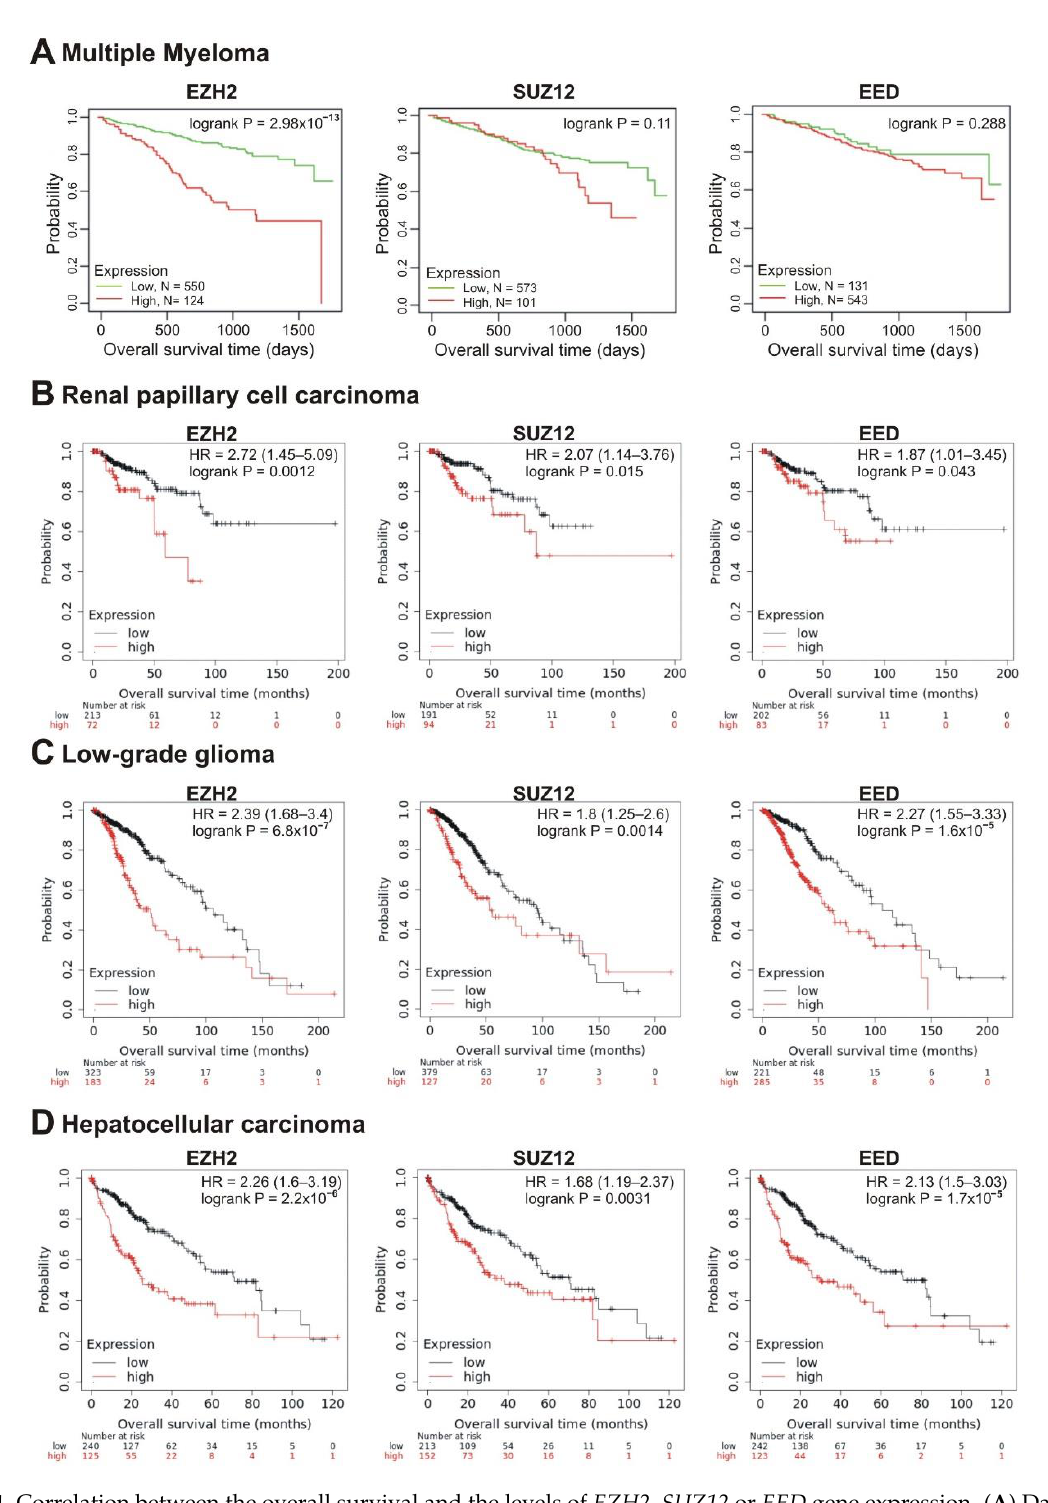
Figure 4. Correlation between the overall survival and the levels of EZH2 , SUZ12 or EED gene expression. ( A ) Data from the Multiple Myeloma Research Foundation CoMMpass trial (NCT01454297; version IA11a). The patients were divided into two cohorts — with low (green) or high (red) levels of gene expression. ( B – D ) The analysis was performed using the KMplot resource for renal papillary cell carcinoma ( B ), low-grade glioma ( C ) and hepatocellular carcinoma ( D ). The cohort with low level of gene expression is colored in black, cohort with high expression is colored in